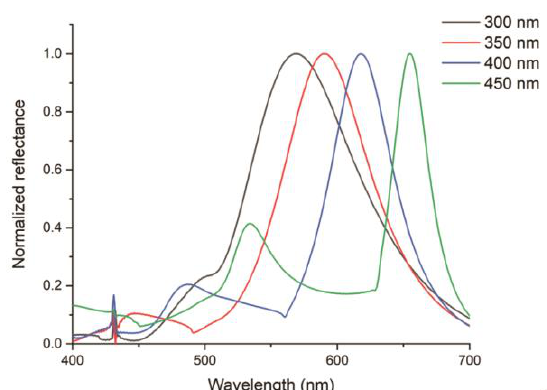
Figure 4. FDTD simulation results of the change of peak reflectance of Ag nanoislands with re- spect to the change of their spatial period (300 nm, 350 nm, 400 nm, and 450 nm,